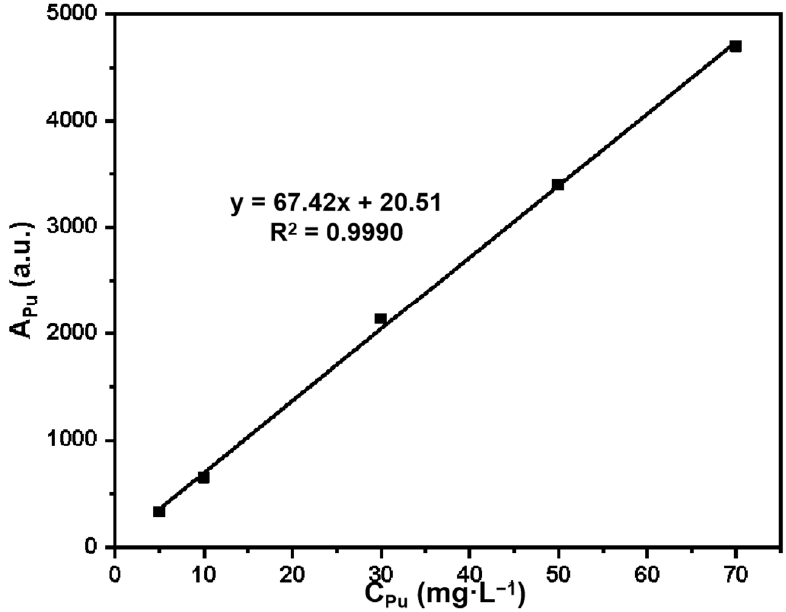
Figure 1. Standard curve for Pu(IV) analysis by X-ray fluorescence spectroscopy.